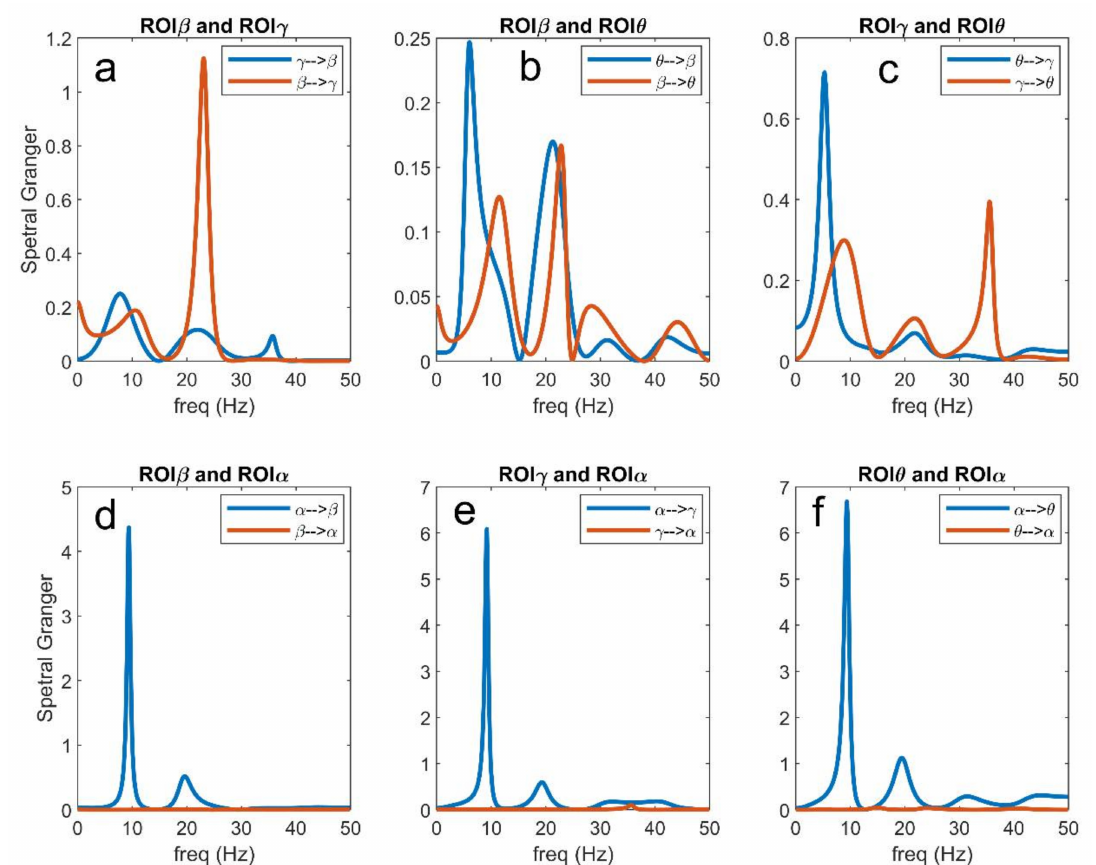
Figure 13. Values of connectivity among the ROIs estimated with the spectral Granger causality, with reference to the network in Figure 2A but with the input to ROI α increased from 200 to 400. The values are plotted as a function of frequency (note the use of different y -axes to emphasize the different cases). From the comparison of these panels with those in Figure 11 emerges that: the α rhythm transmitted from ROI α to the other regions becomes almost sinusoidal (high and sharp spectra ( d – f )); the rhythm exchange between ROI β and ROI γ ( a ) and between ROI θ and ROI γ ( c ) are significantly altered, with the presence of components in the α range; finally, spurious connections appear between ROI β and ROI θ ( b ), both in the β and α ranges. Comparing this figure with the corresponding bottom panel in Figure 10, the spectral Granger causality provides similar information as the temporal Granger causality, but with emphasis on the frequency